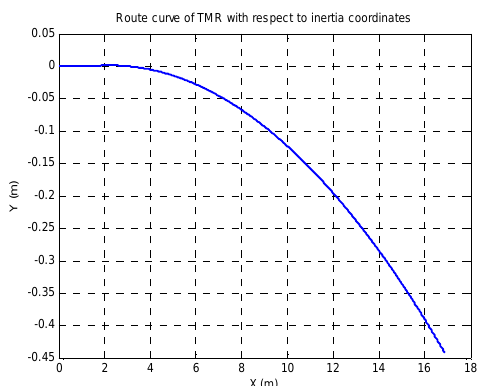
Fig.10. Comparison of real path and reference path on 6 degree slope